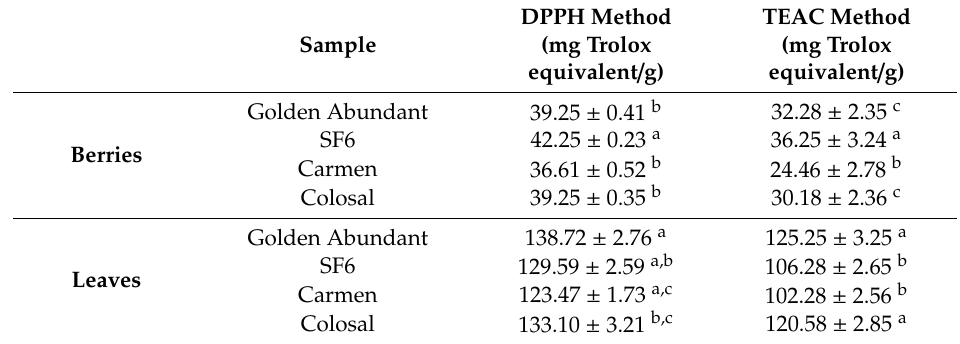
Table 5. Determination of potential for antioxidant activity of extracts of sea buckthorn berries and